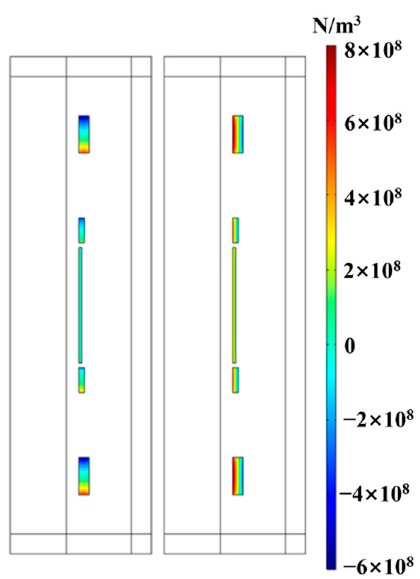
Figure 8. Axial ( left ) and radial ( right ) Lorentz force distributions of the coils. There are 15 resistors placed outside the heat-insulating theater in three groups to provide quench protection. The quench protection circuit diagram is depicted in Figure 9.